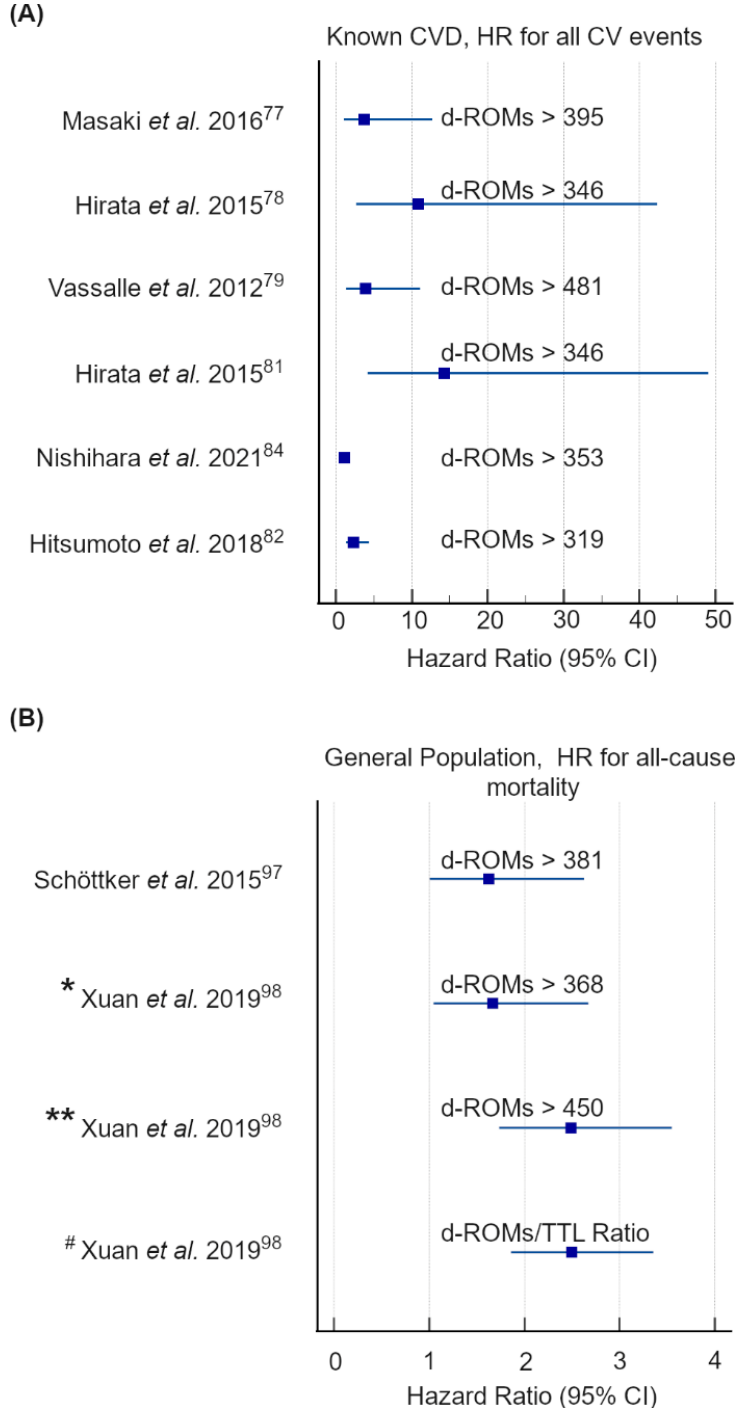
Figure 7. Graphical representation of the data reported in Table 3. The data were grouped depending on population groups (small cohorts of individuals with known cardiovascular disease (CVD) and general-population-based cohorts), clinical outcomes (all cardiovascular (CV) events, cardiovascular mortality, and all-cause mortality) and statistical parameters (HR). ( A ) Hazard ratio and 95% CI for all CV events in small cohorts of individuals with known CVD [77–79,81,82,84]; ( B ) hazard ratio and 95% CI for all-cause mortality in general-population-based cohorts [97,98]. * ESTHER cohort; ** DIANA cohort; # Meta-analysis of ESTHER and DIANA cohorts with HR provided for the d-ROM/TTL ratio top tertile.